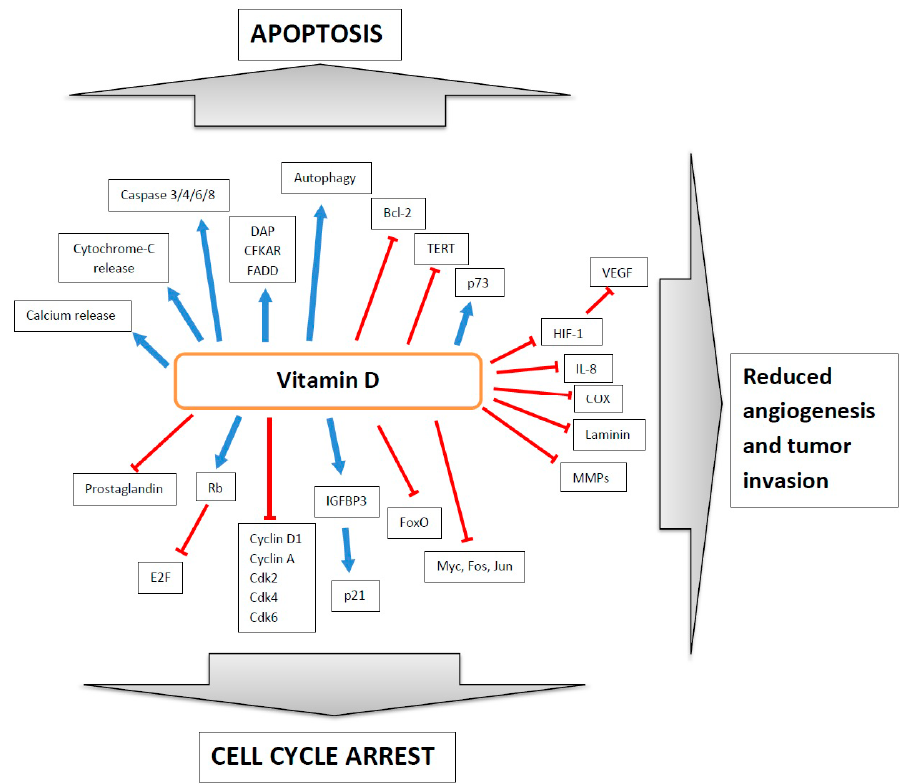
Figure 3. Anticancer action of vitamin D. Sharp blue arrows—stimulation, blunt red arrows— inhibition. DAP—death-associated protein-3; CFKAR—caspase 8 apoptosis-related